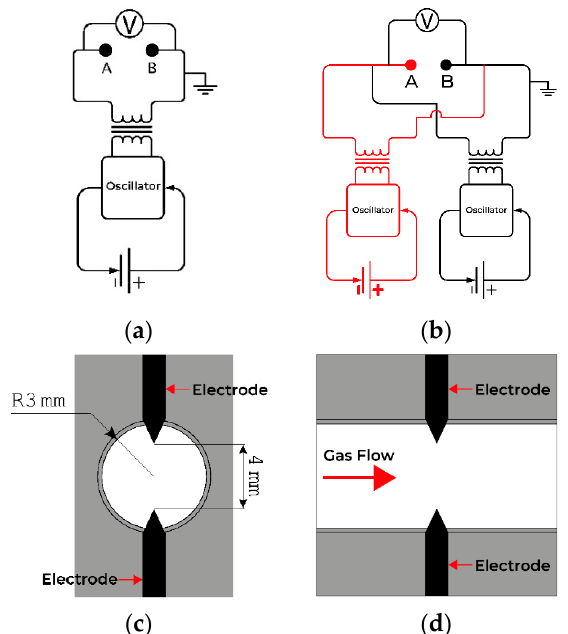
Figure 1. Diagram of a high voltage circuit with 42 Watts of power ( a ) and 85 Watts of power ( b ), and diagram of the plasma chamber, showing the front ( c ) and side ( d ).